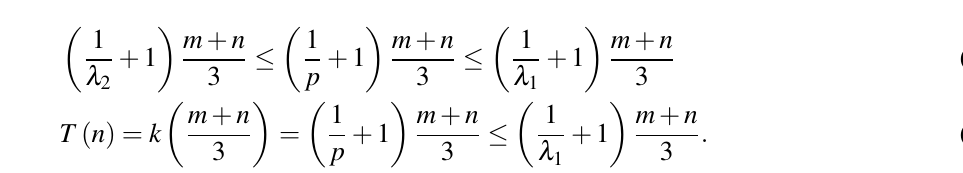
Algorithm 12: Marked Random Search